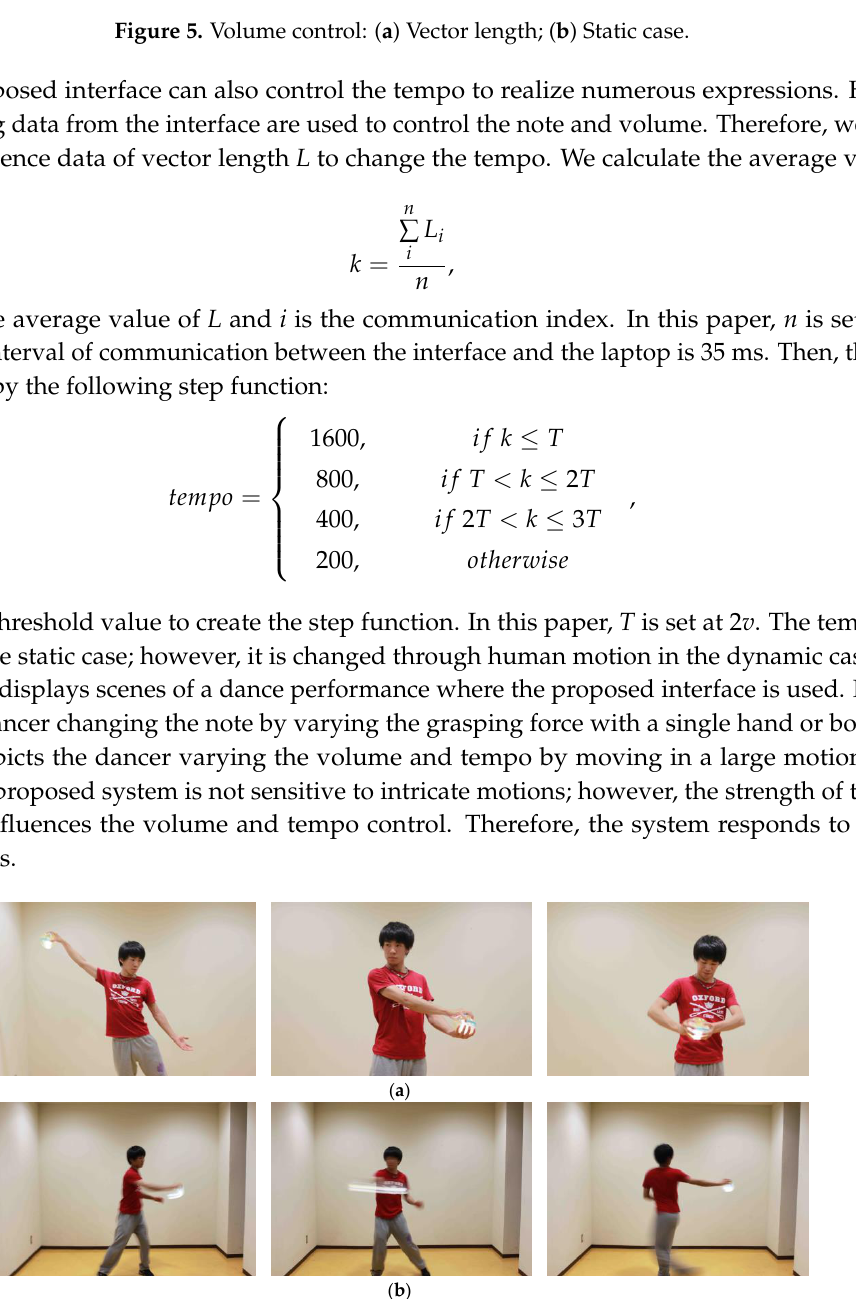
Figure 6. Scenes of musical performances using TwinkleBall: ( a ) Grasping motions; ( b ) Moving